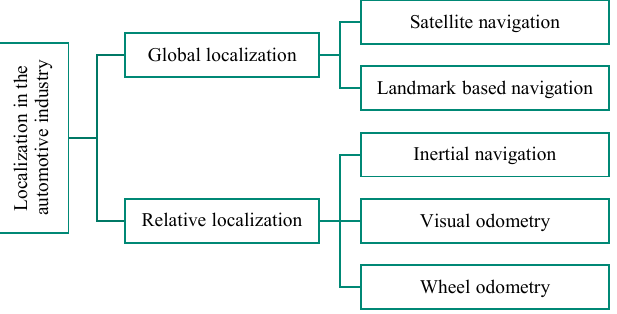
Figure 2. Classification of localization methods according to Ref. [5].